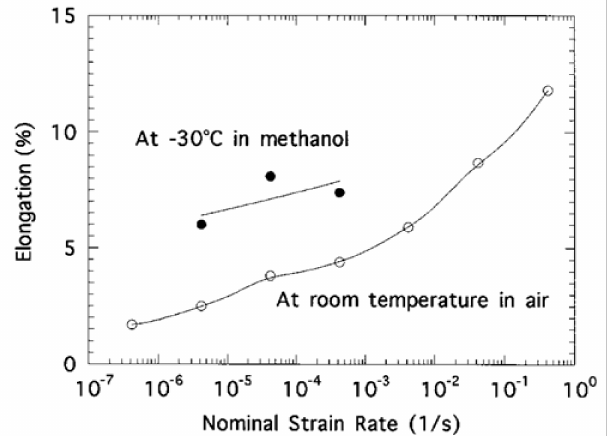
Figure 10. The effect of strain rate on ductility at room temperature and − 30 ◦ C, respectively, for an extruded low-temperature annealed Fe-40Al-0.6C alloy. Reprinted with permission from ref. [12]. Copyright 1998